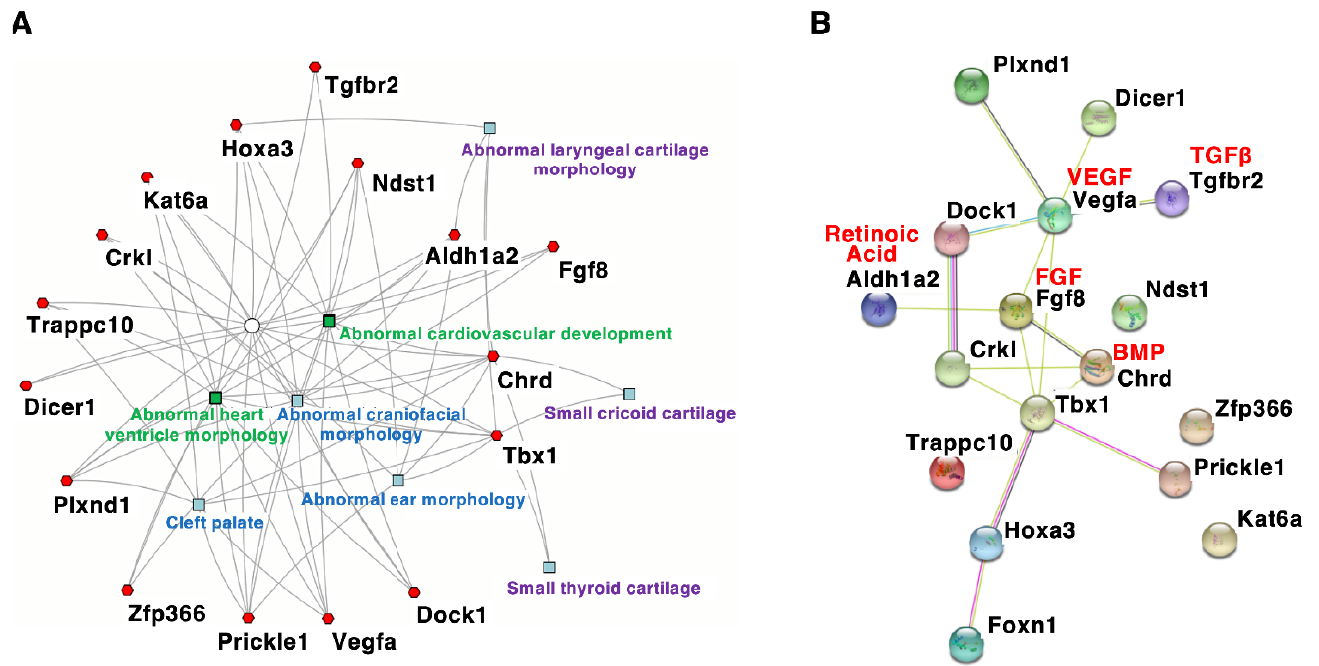
Figure 2. Interaction network of genes associated with DGS/VCFS phenotypes in mice. ( A ) A gene-based network where each gene connects to a feature. The network was constructed using ToppCluster (https://toppcluster.cchmc.org/ accessed on 6 May 2022). Mouse phenotypes are shown in the network. ( B ) The protein–protein interaction network was constructed using the STRING tool (https://string-db.org/ accessed on 6 May 2022). Genes associated with DGS/VCFS phenotypes in mice (Table 4) were the input. Different colors represent different types of evidence of a connection between proteins.